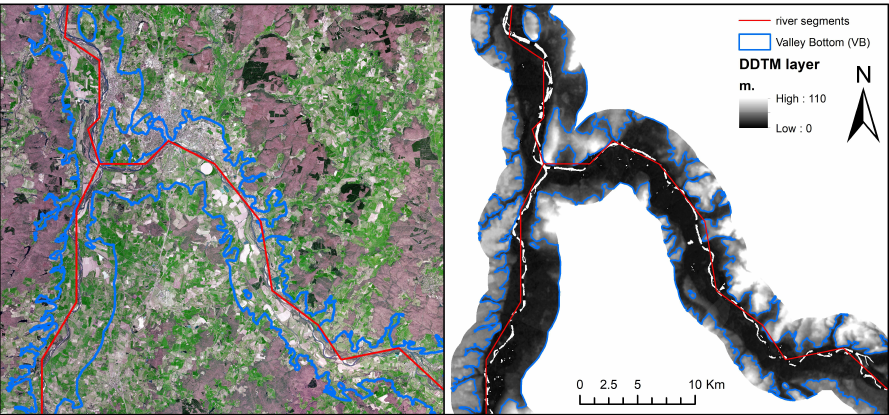
Figure 5. Example of the “Fluvial corridor” toolbox results: VB (blue) and river segments (red) shapefiles overlaid on Copernicus VHR mosaic ( left ) and DDTM layer ( right